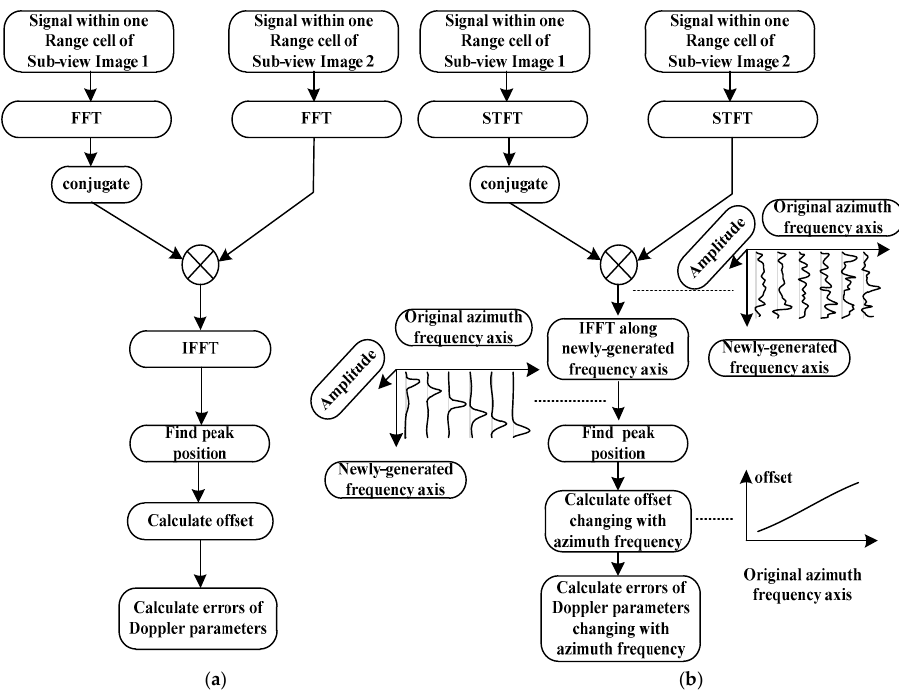
Figure 3. The flow charts of the basic MAM method and the EMAM method. ( a ) The basic MAM method; ( b ) the EMAM method. Sensors 2019 , 19 , 213